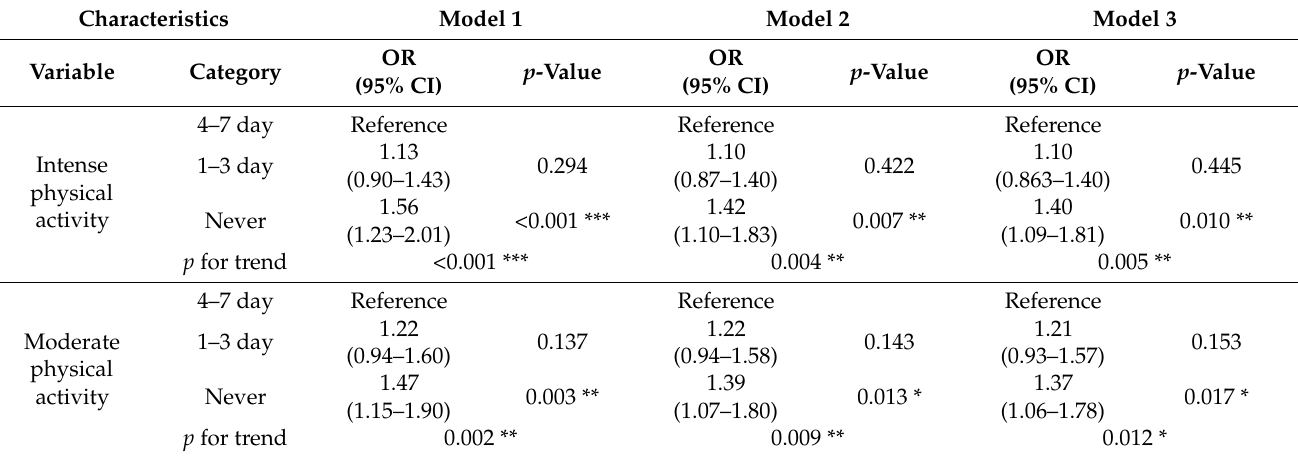
Table 3. Odds ratio (95% confidence interval) of physical activity and vitamin D deficiency